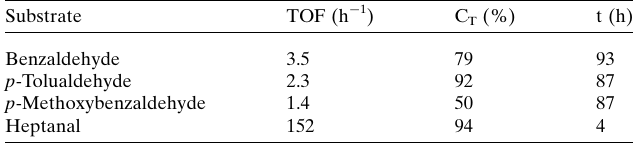
Table 3 Aldol condensation with acetone over catalyst 2 .